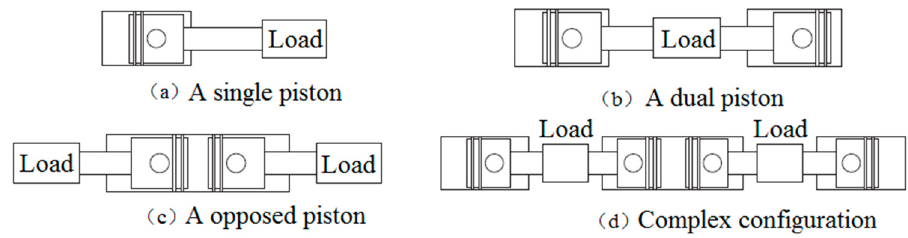
Figure 10. The structural form of an HFPE [24].